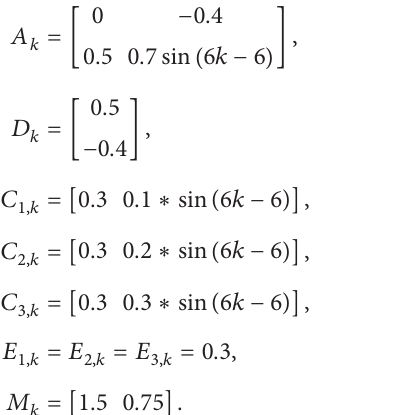
Algorithm 11 ( 𝐻 ∞ Filter Design Algorithm